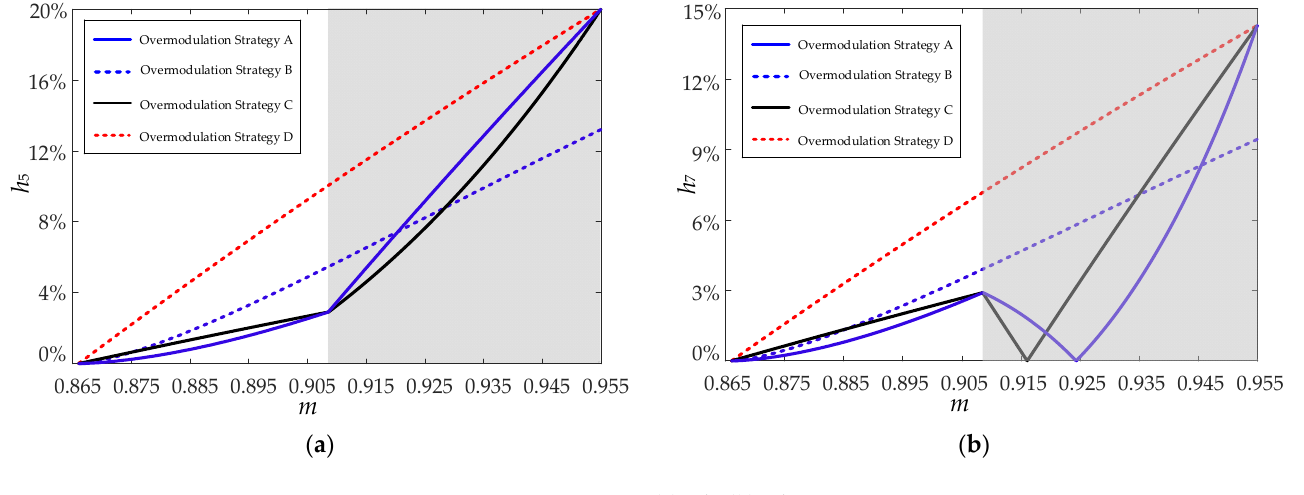
Table 1. Parameters of experiment